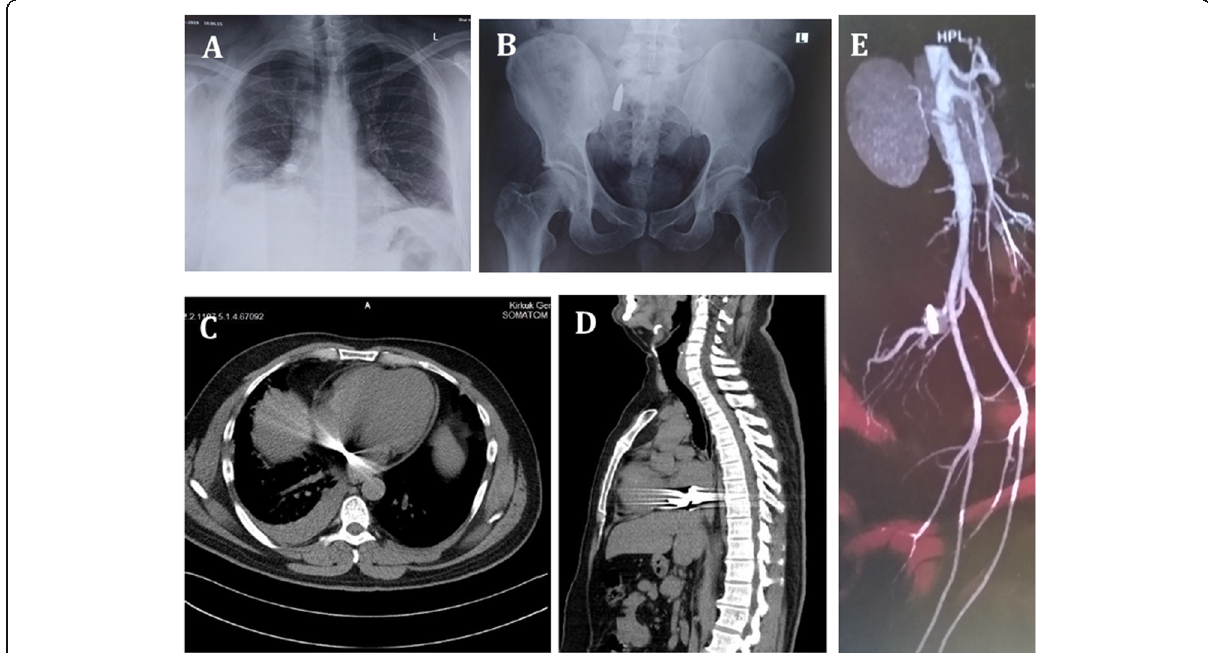
Fig. 1 a Right-sided hemothorax drained by closed tube thoracostomy. b Bullet migrated to right pelvis. c , d First day CT scan of the chest showing a bullet in the right atrium with moderate right sided hemothorax. e CT angiography showing the bullet adjacent to iliac artery mostly in the right internal iliac